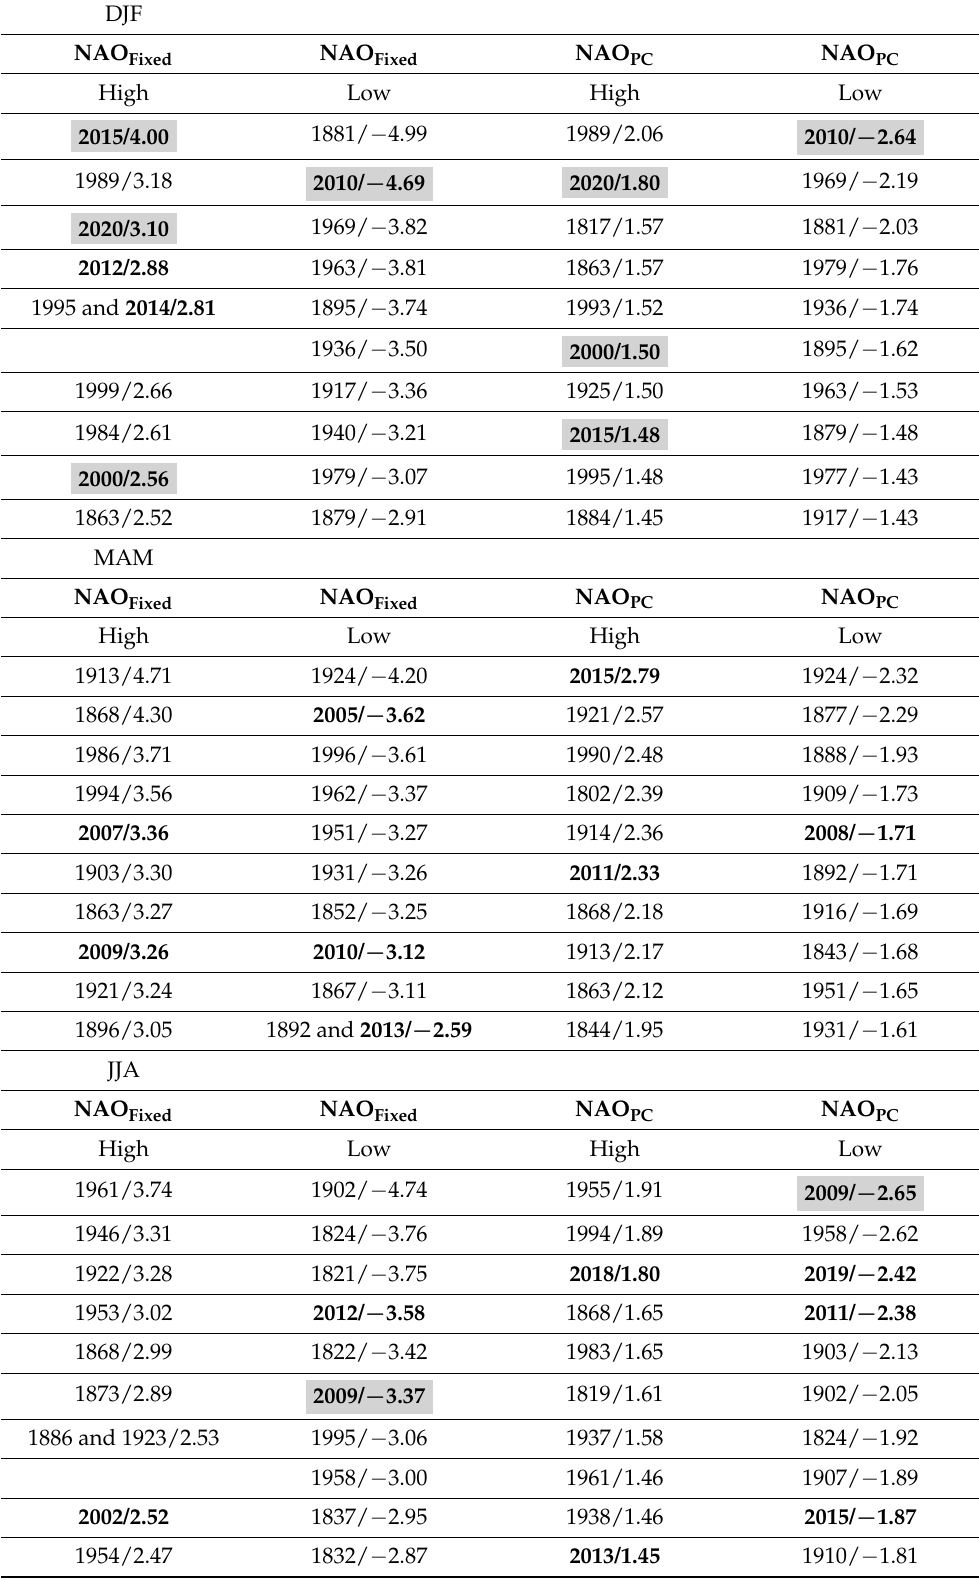
Table 5. Ten highest and ten lowest NAO Fixed and NAO PC years/values for each season for the period 1800–2020. Years since 2000 inclusive are emboldened, and these years are also shaded where they feature in both GB